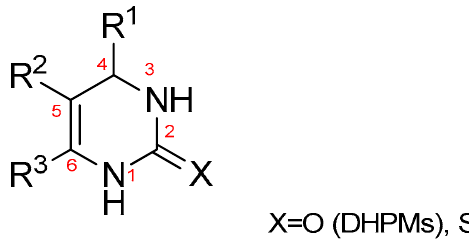
Figure 1. The structure of a 3,4-dihydropyrimidin-2(1H)-one compound (DHPM) and its thione derivatives.